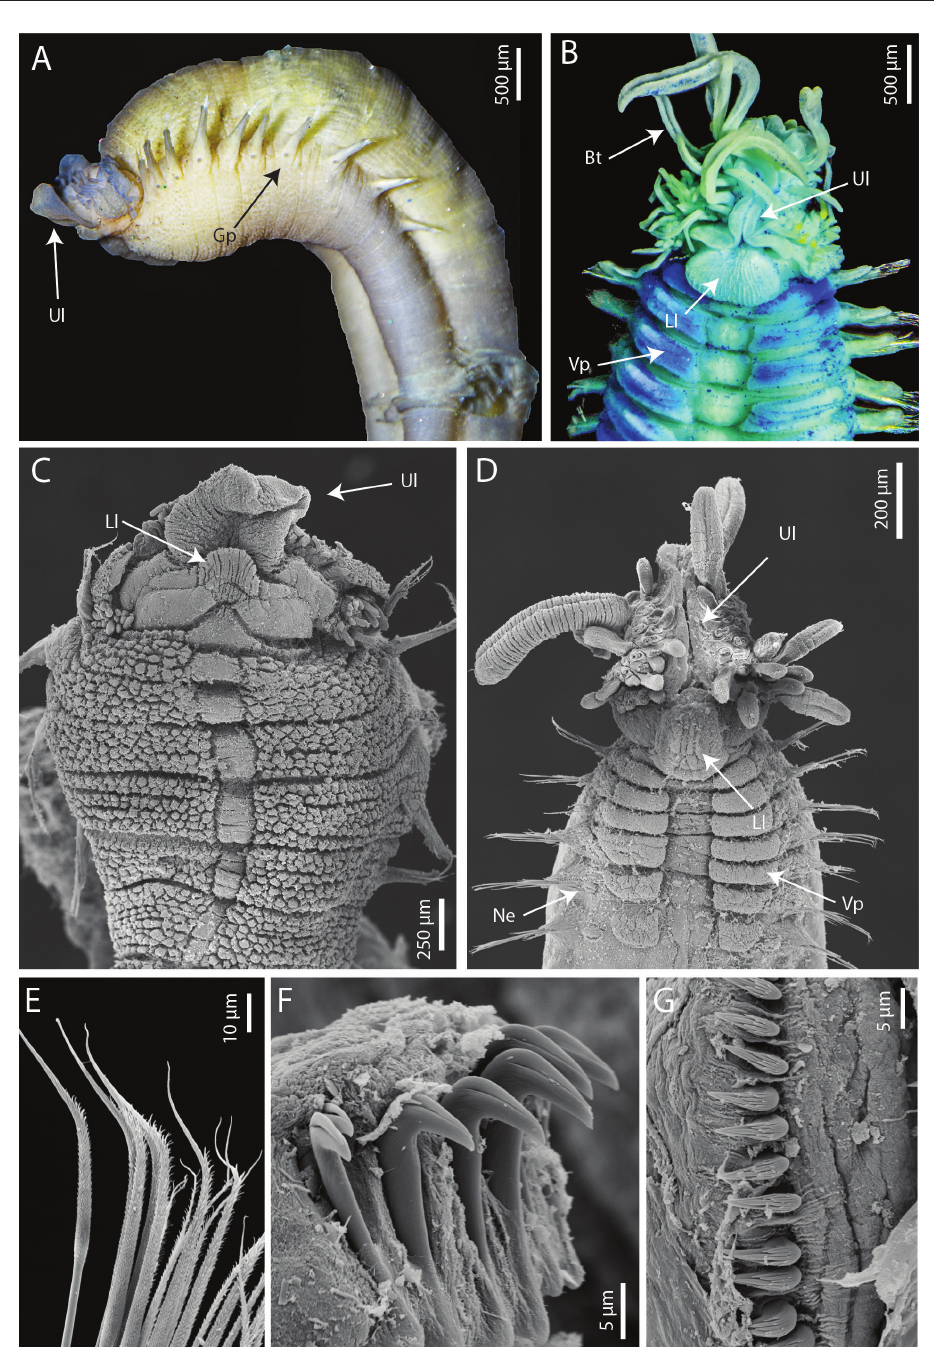
Fig. 2. Diversity of Polycirridae Malmgren, 1866. A . Amaeana gremarei Lavesque, Hutchings, Daffe & Londoño-Mesa, 2020, anterior end, lateral view (MNHN-IA-TYPE 2006). B . Polycirrus gujanensis Lavesque, Hutchings, Daffe & Londoño-Mesa, 2020, anterior end, ventral view (MNHN-IA-TYPE 2013). C . Amaeana gremarei , anterior end, ventral view (AM W.53111). D . Polycirrus idex Lavesque, Hutchings, Daffe & Londoño-Mesa, 2020, anterior end, ventral view (AM W.53127). E . Polycirrus glasbyi Lavesque, Hutchings, Daffe & Londoño-Mesa, 2020, notochaetae SG V (AM W.53118). F . Polycirrus catalanensis Lavesque, Hutchings, Daffe & Londoño-Mesa, 2020, abdominal uncini (AM W.53113). G . Polycirrus glasbyi , thoracic uncini (AM W.53118). Abbreviations: Bt = buccal tentacles; Gp = genital papilla; Ll = lower lip; Ne = neuropodia; Ul = upper lip; Vp = ventral